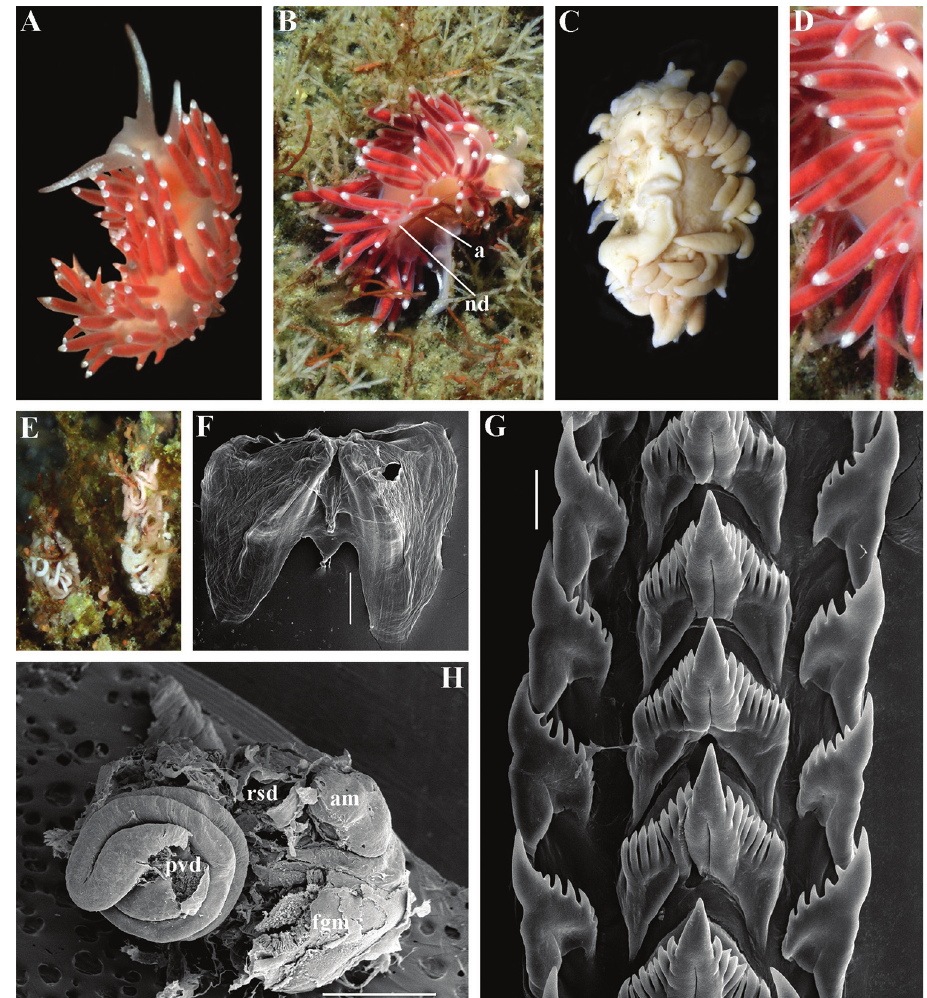
Figure 31. Microchlamylla gracilis zfi subsp. n. Arctic, Franz Josef Land. ZMMU Op-501, specimen 11 mm length (fixed): A dorsal view (live) B lateral view (live) C ventral view (fixed) D details of cerata E egg masses on hydroids F jaws, SEM G radular teeth, posterior part, SEM H reproductive system. Ab- breviations: a anus am ampulla fgm female gland mass nd discontinuous notal edge pvd prostatic vas deferens rsd distal receptaculum seminis. Scale bars: F = 300 μm; G = 30 μm; H = 1 mm. Photos of living specimens and eggs by O.V. Savinkin, other photos and SEM images by A.V.